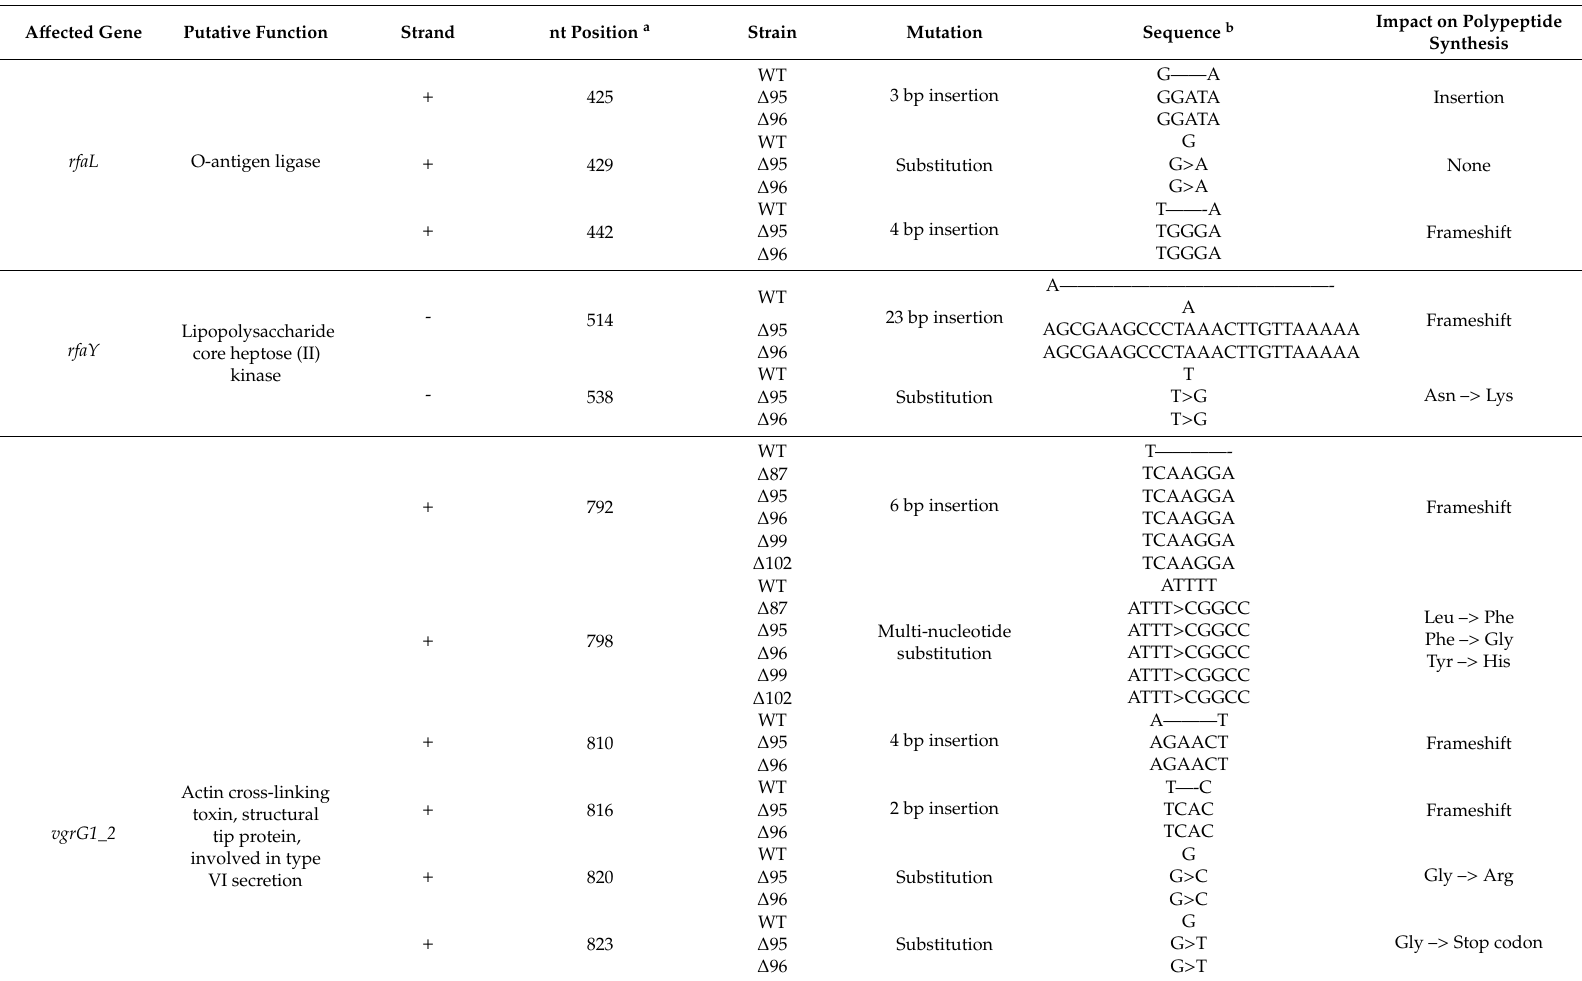
Table 1. Mutations in genes involved in lipopolysaccharide synthesis and type VI secretion system of the S . Agona bacteriophage-insensitive mutants (BIMs). Mutations presented possess a minimum quality score of 20 and a minimum mapping coverage of